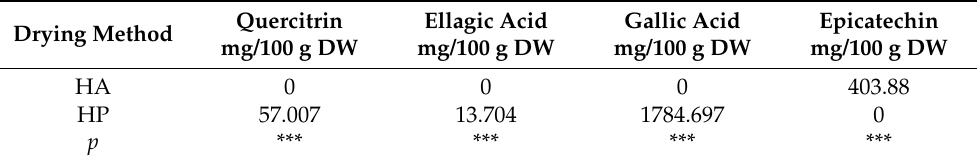
Figure 1. Total bioactive compounds detected by means of HPLC analysis in L. angustifolia hot air-dried and heat pump-dried flowers extracted by decoction in Susa ( A ), Stura ( B ), and Tanaro ( C ) selections. The colored number above the columns indicates the detected value of each bioactive compound (yellow for hot air drying, blue for heat pump drying). Values are expressed in mg/100 g of dry flowers. Table 4. Differences in the total detected bioactive compounds between the two drying methods. Values are expressed as means of the three selections values. HA = hot air dried; HP = heat pump dried. Data are based on dry weight